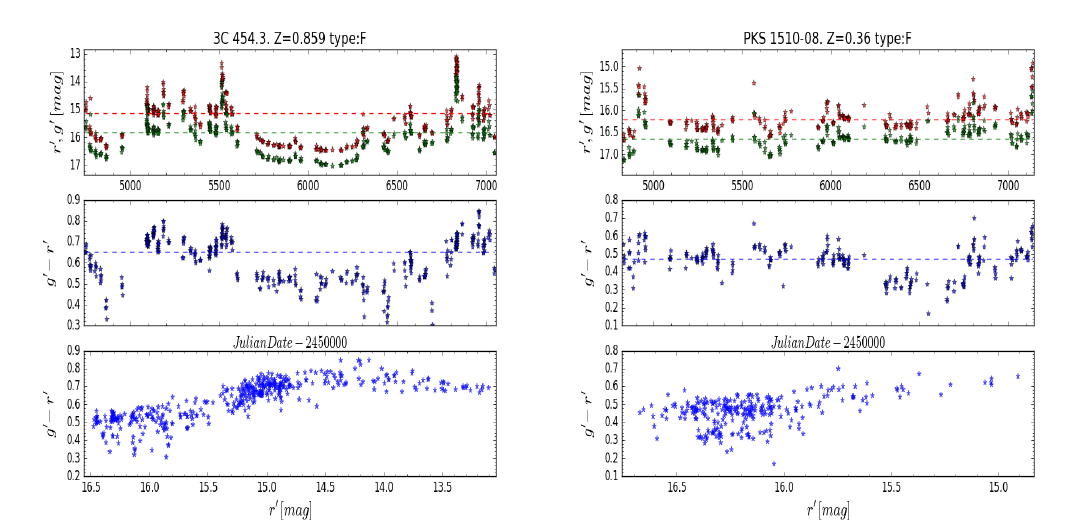
Figure 5. Colour light curves for two FSRQ type objects, built with the synthetic photometry data obtained from the Steward Observatory spectra. The bottom panel is a colour-magnitude diagram containing all data points.